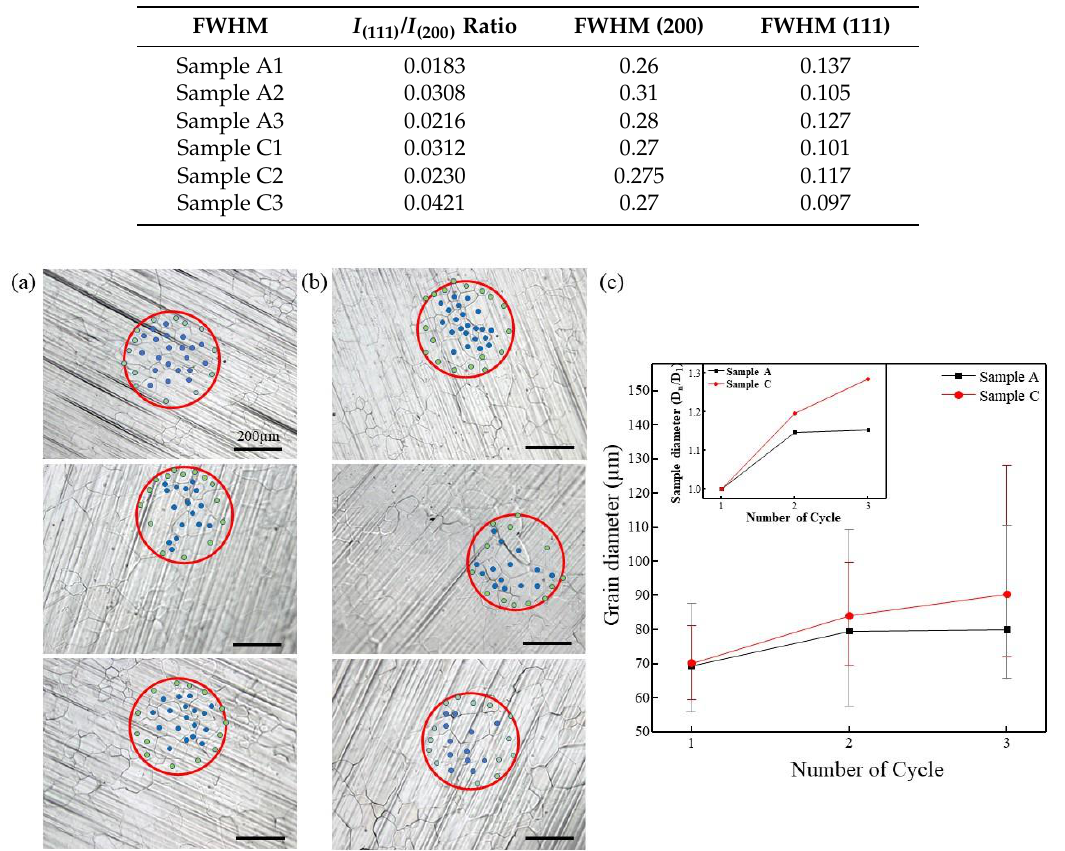
Table 2. Intensity ratio and full width at half maximum (FWHM) related to Figure 2b.